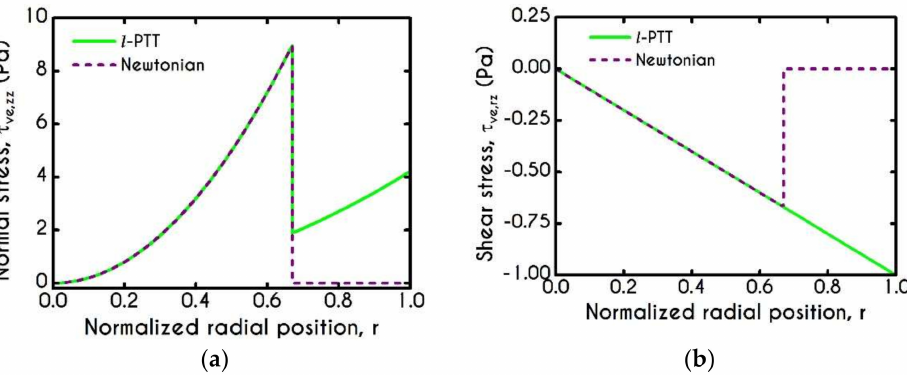
Figure 4. ( a ) Normal viscoelastic stress τ ve,zz , and ( b ) Shear viscoelastic stress τ ve,rz for R = 20 µ m, J = 5 × 10 5 Pa/m, and H c =